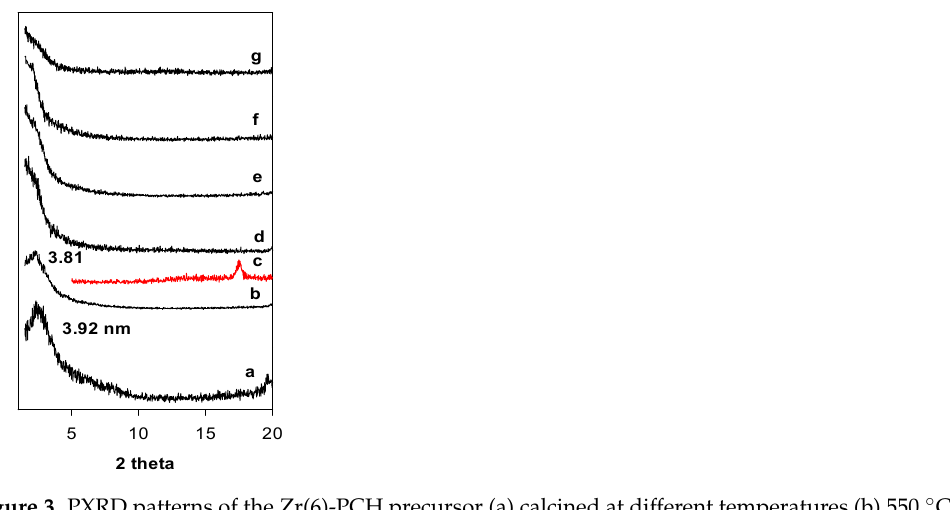
Figure 3. PXRD patterns of the Zr(6) ‐ PCH precursor (a) calcined at different temperatures (b) 550 °C, (d) 650 °C, (e) 750 °C, (f) 850 °C, and (g) 900 °C. (c) Corresponds to tetragonal ZrO 2 phase.